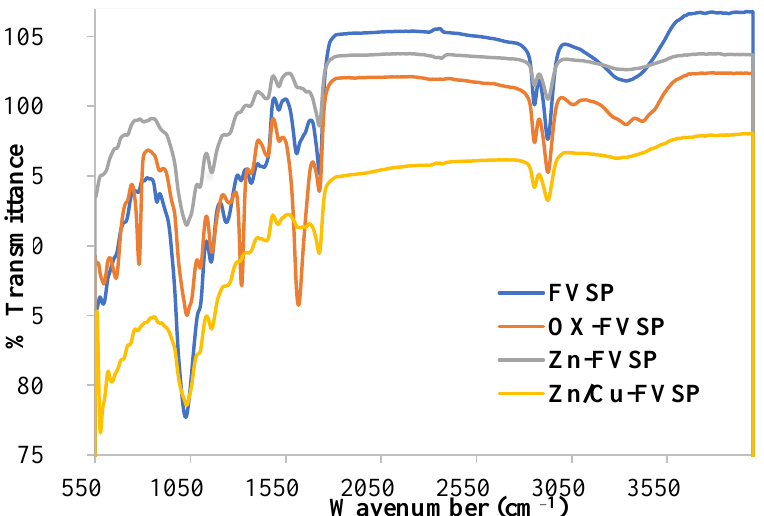
Figure 2. FT-IR spectra of the adsorbent used in the Congo red adsorption.